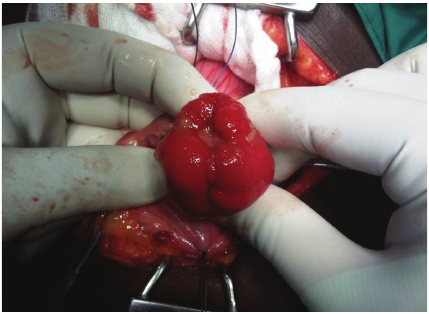
Figure 1: Intraoperative photo of gastric lipoma with central ulcer bleeding.